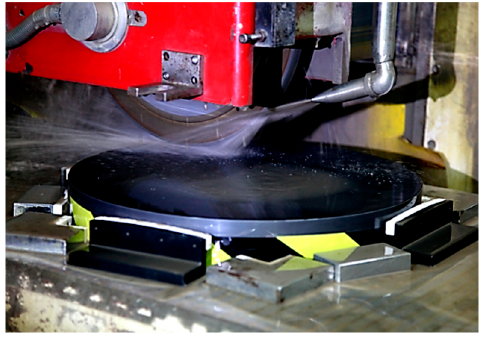
Figure 18. Photos of the ultra-precision grinding process.